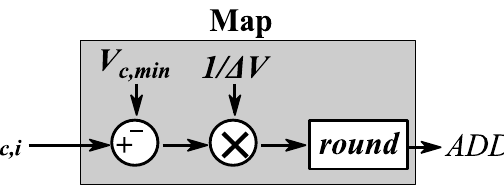
Figure 5. Evaluation of the memory address ADDRi. V c,min is subtracted to the measured capacitor voltage v c,i and the result is divided by the amplitude of the sub-ranges Δ V .